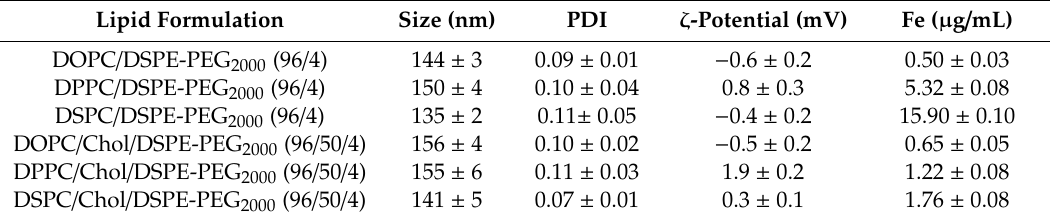
Table 2. List of formulations used for the preparation of magneto-liposomes (MLs) with corresponding physicochemical properties. Hydrodynamic size, polydispersity index (PDI) and zeta potential as determined using dynamic light scattering (DLS). Fe content in MLs as measured using inductively coupled plasma mass spectrometry